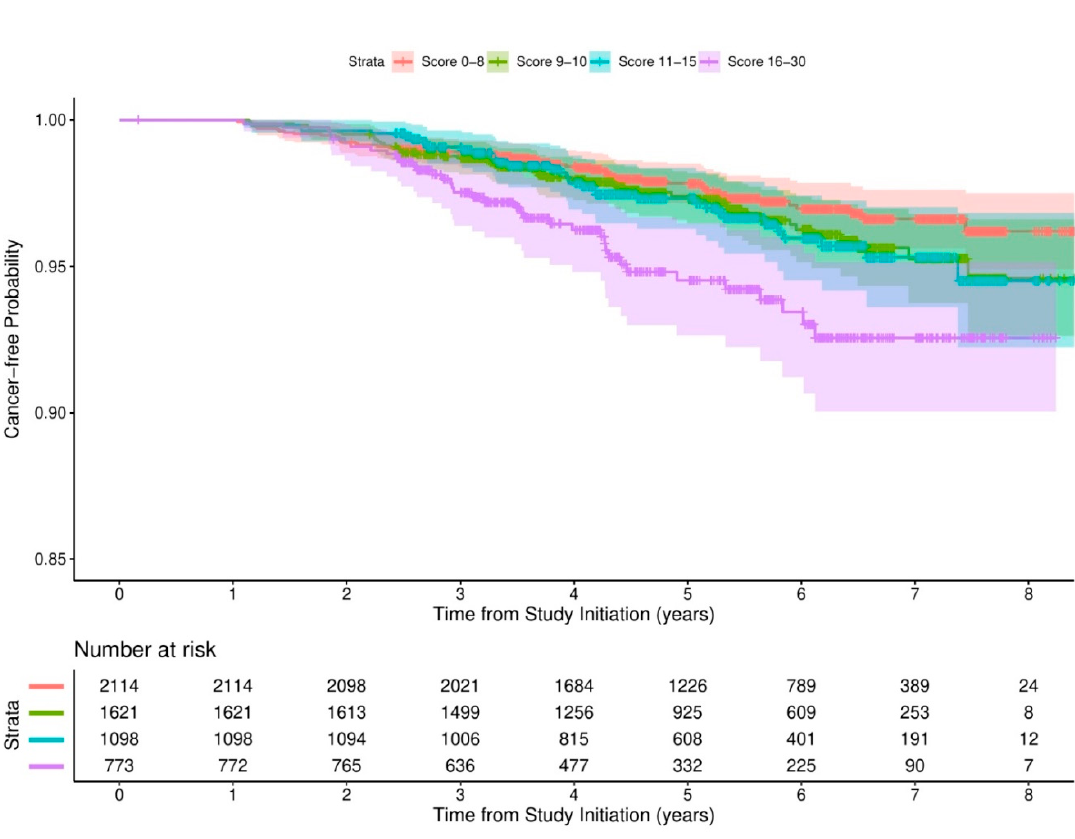
Table 5. Comorbidity scores and the risk of cancer incidence.